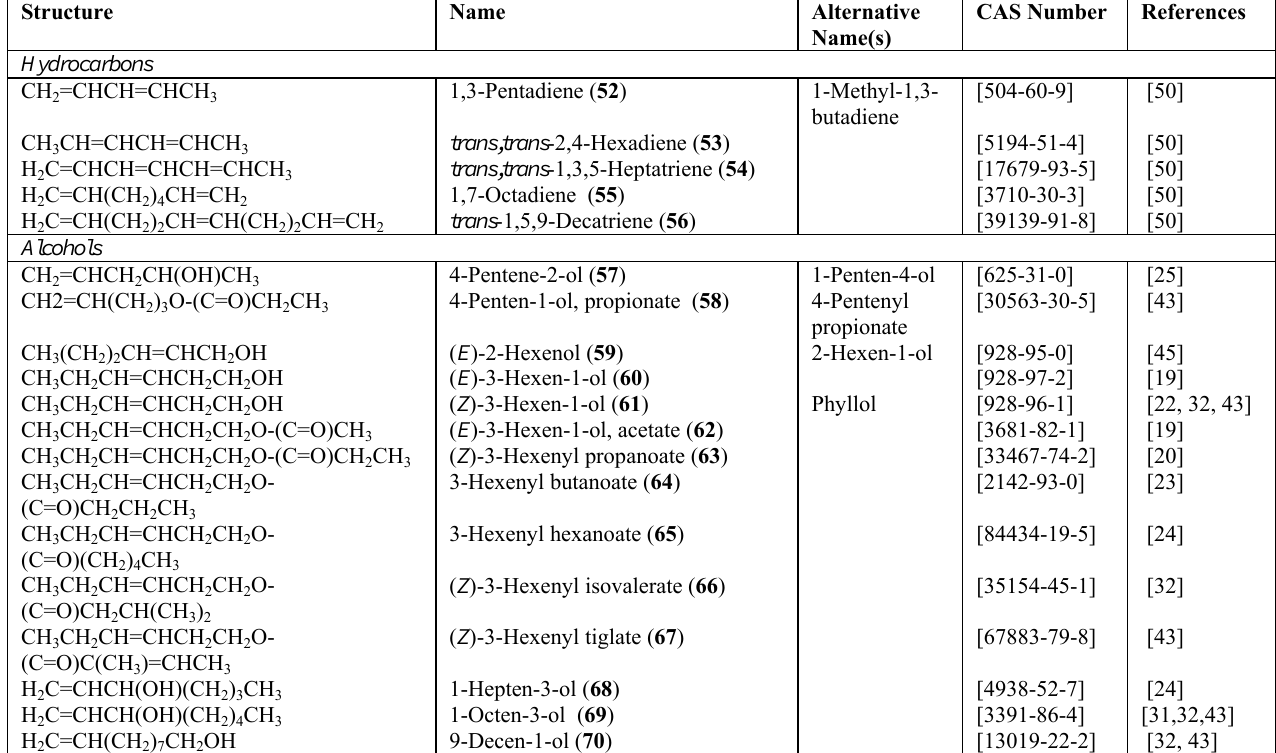
Table 4. Unbranched Alkenic Hydrocarbons and